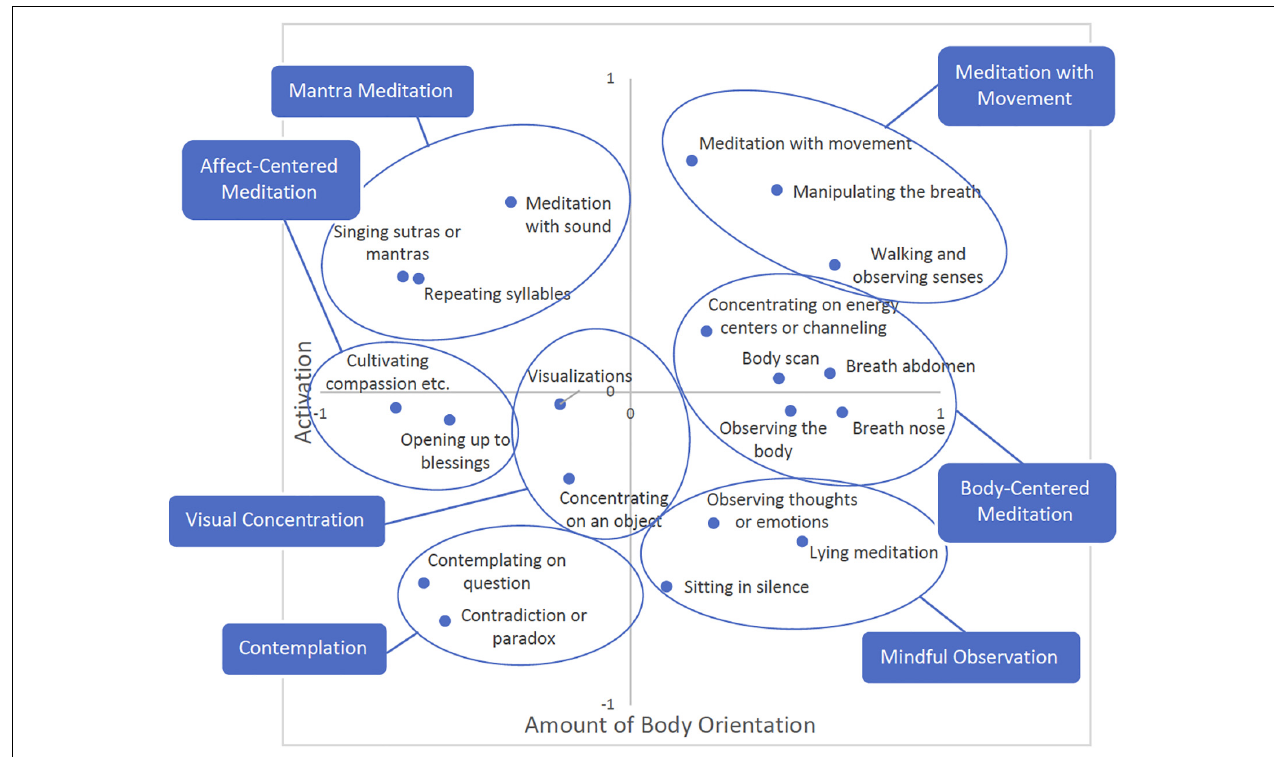
FIGURE 2 | Overall multidimensional scaling (MDS) solution with indicated clusters and